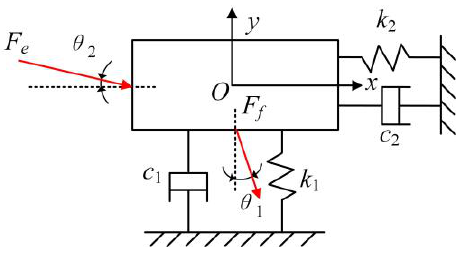
Figure 6. Movement process of blades in a single cycle when using forced displacement biaxial testing device. a is hydraulic loader of edgewise, b is support frame, c is hydraulic loader of flapwise, d is support frame, e is cross section of blade and fixture.